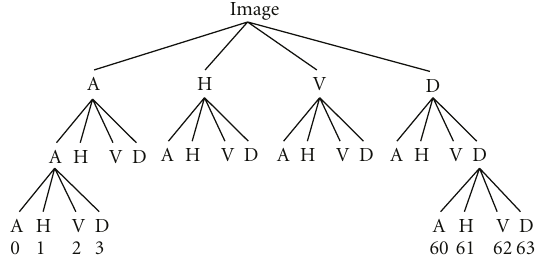
Figure 9: Full 3-level wavelet packet decomposition tree: the low- pass subbands (approximations) are denoted by A and the high-pass ones are represented following their directions—H (horizontal), V (vertical), and D (diagonal).